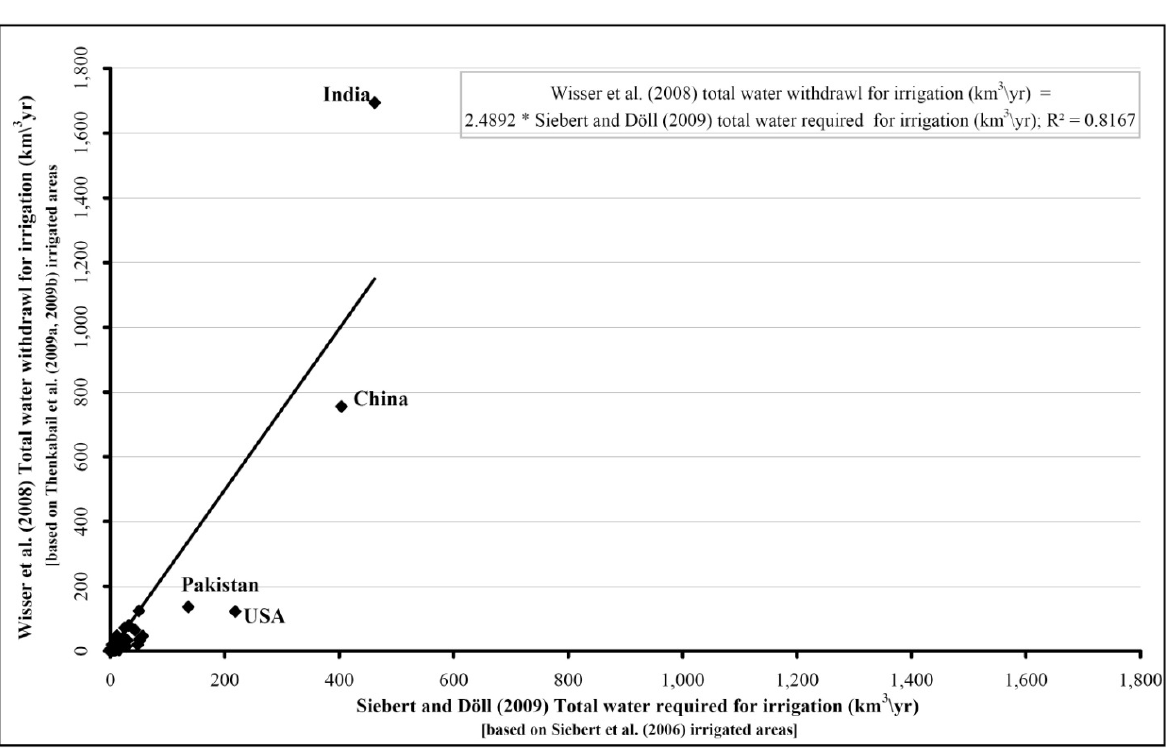
Figure 16. Water withdrawal [96] versus water required [49,97] by irrigated crops for the 197 countries in the World. Water withdrawals always much higher than water